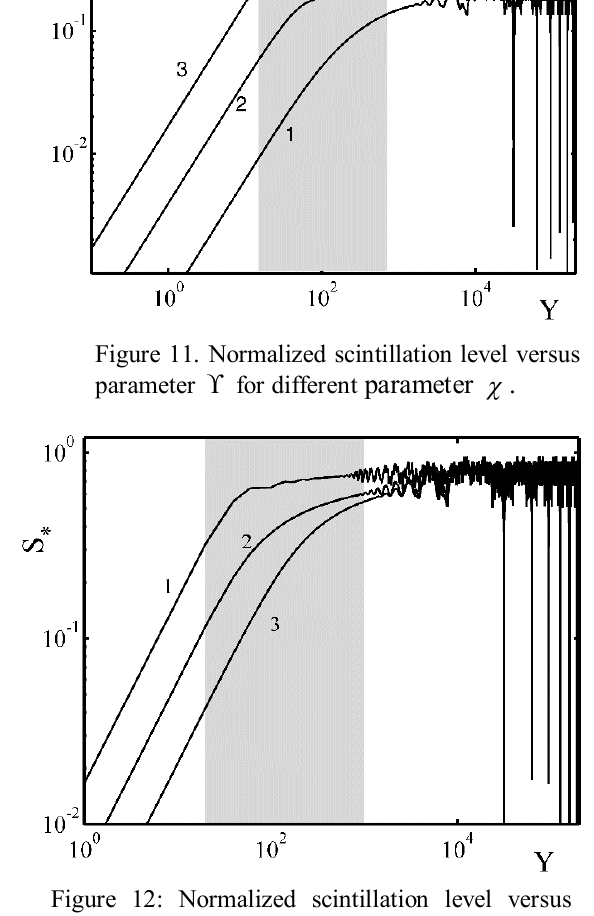
Figure 14: Power spectrum of the intensity fluctuations as log-log plots of the frequency parameter . Irregularities are moving along the X -axis (solid line); along the Y -axis (dashed line).